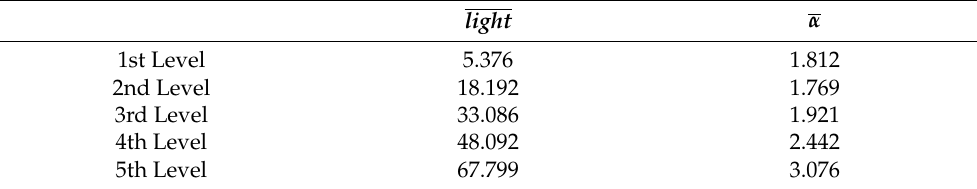
Table 2. The candidate cutoff values for the NTL image and the resulting power law exponents at different levels based on the head/tail breaks method. (Note: light : The average of lightness thresholds at each level for 20 images; α : The average of power-law exponent of hotspot area for 20